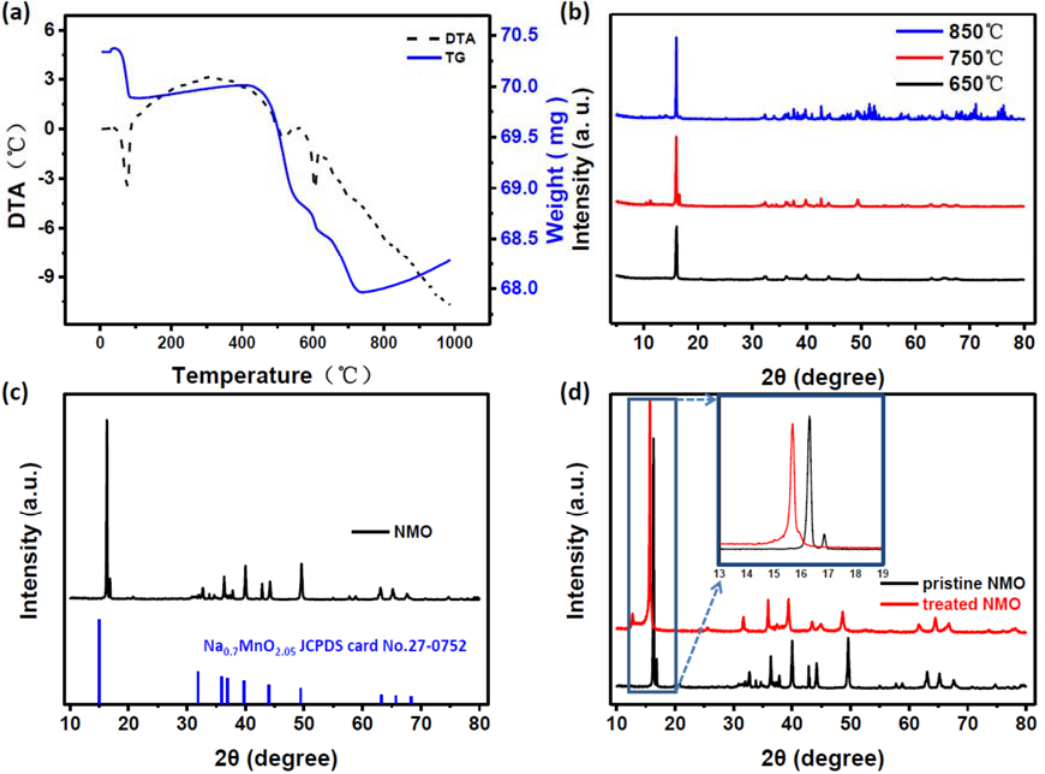
Figure 1. ( a ) Differential thermal analysis (DTA) results for NMO precursor mixtures; ( b ) X ‐ ray powder diffraction analysis at different sintering temperatures; ( c ) comparison of NMO ʹ s X ‐ ray powder diffraction analysis results with the corresponding PDF card; ( d ) comparison of the results of X ‐ ray powder diffraction analysis before and after treatment.